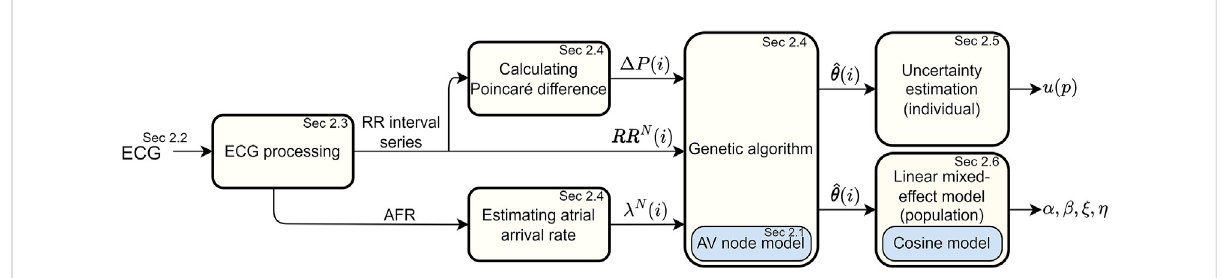
FIGURE 1 A fl owchart of the overall framework for estimating AV node conduction properties on an individual and a population